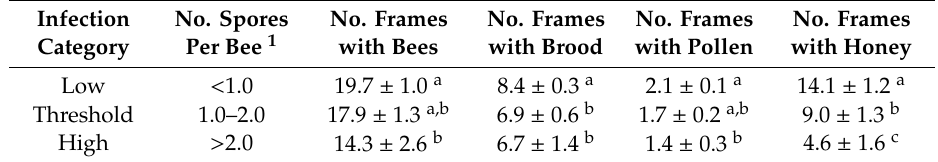
Table 2. Population and food store parameters (mean ± SE) of honey bee colonies categorized by intensity of Nosema ceranae infection (low, threshold, high) in the summer ( n = 172).